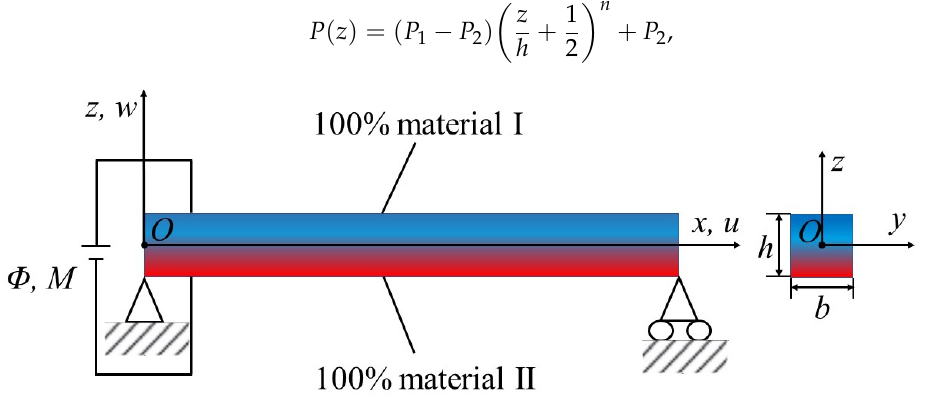
Figure 1. Functionally graded microbeam configuration.